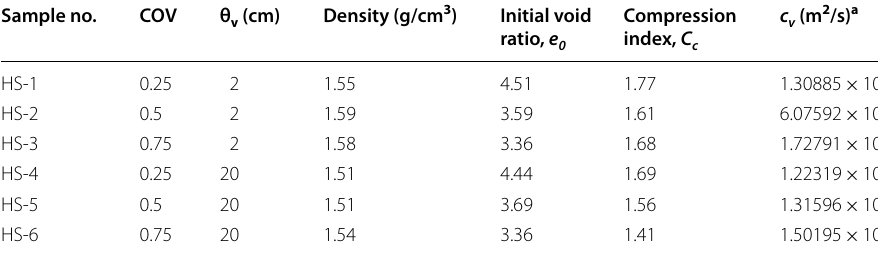
a Coefficient of consolidation at pressure 100 kPa